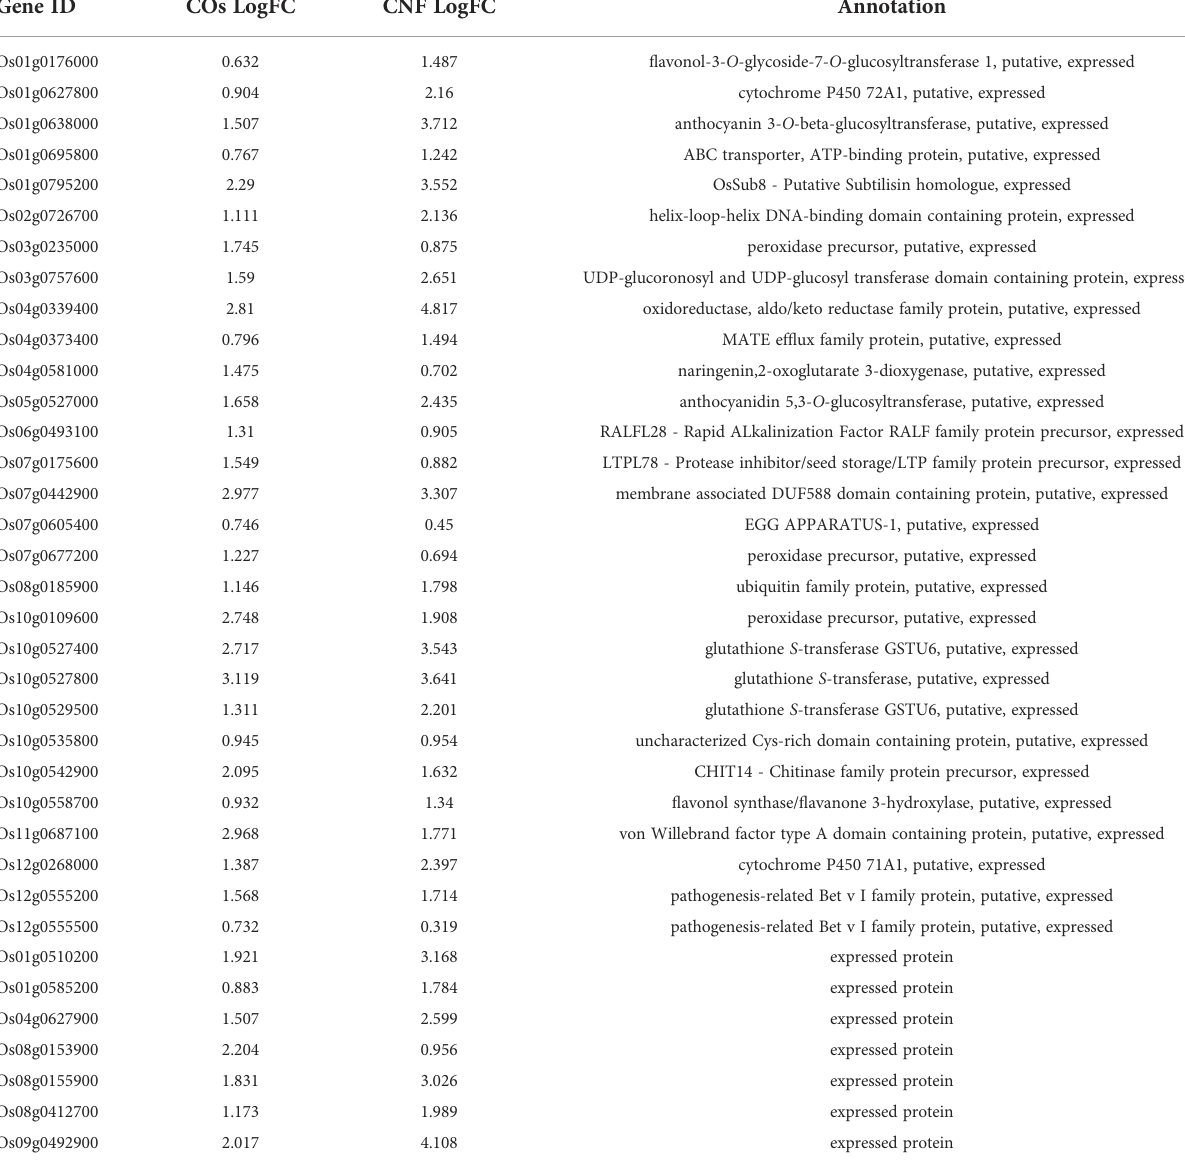
TABLE 1 Expression levels and annotation of genes upregulated by chitin treatment correlated with BTH-induced genes.